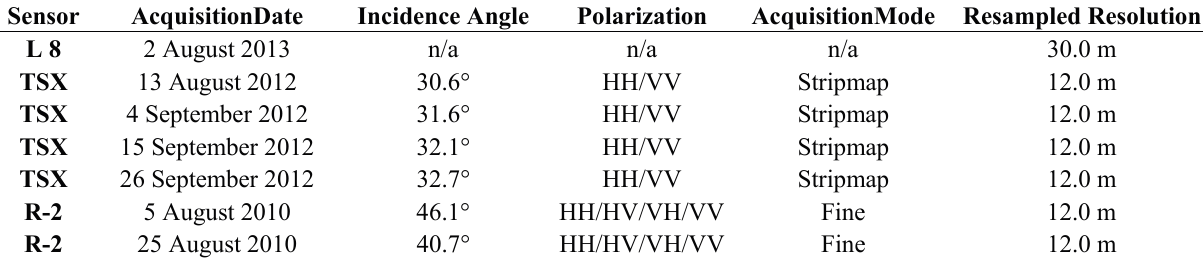
Table 1. Acquisition parameters of TerraSAR-X (TSX), Radarsat-2 (R-2) and Landsat 8 (L 8)